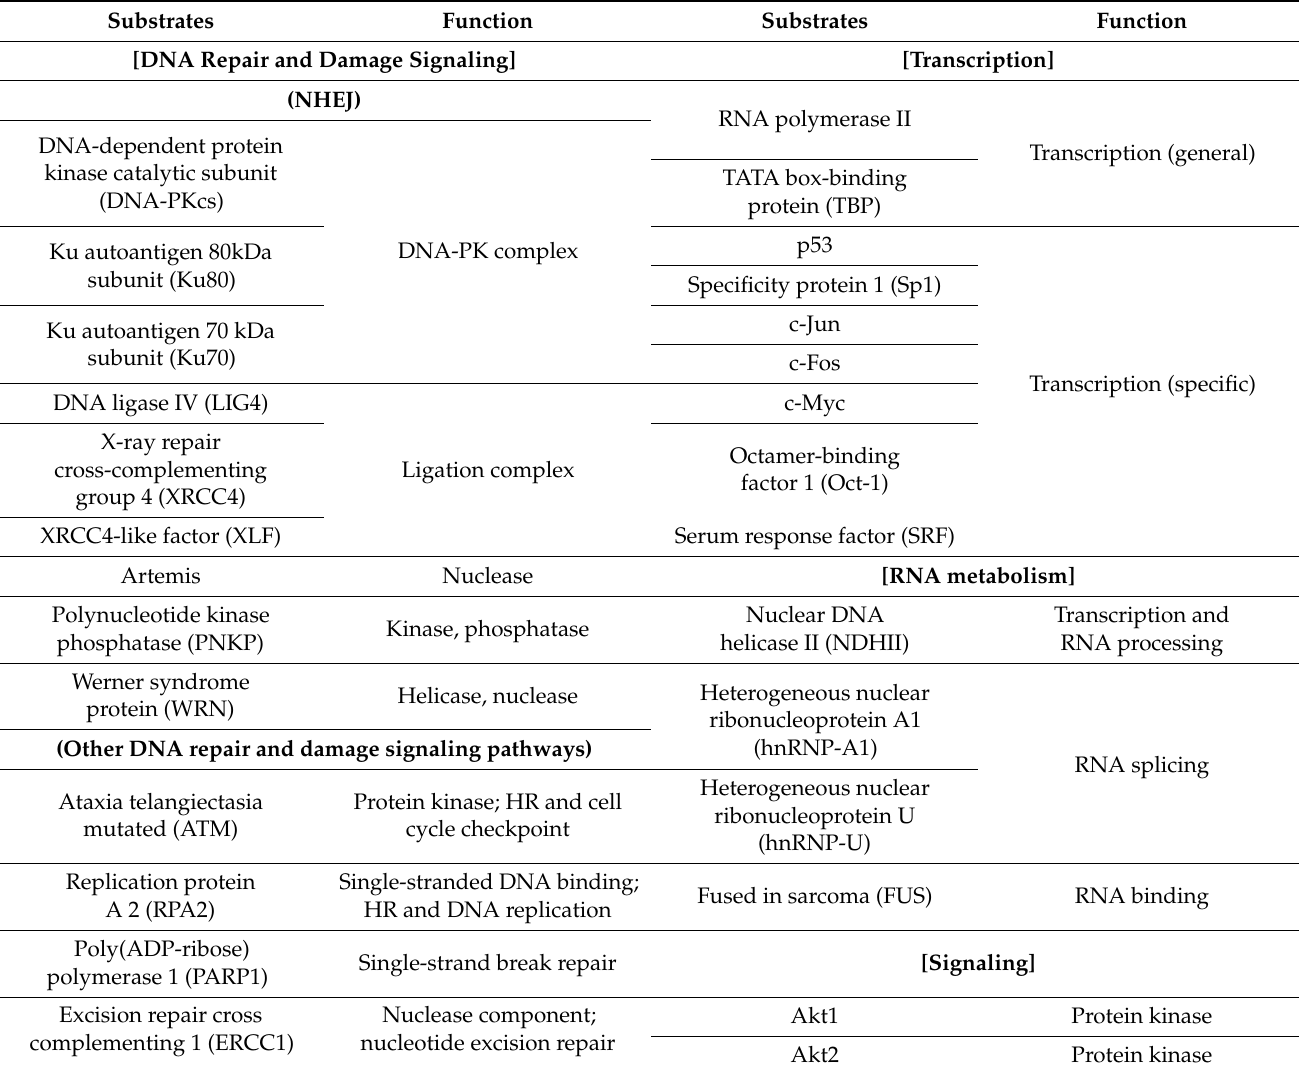
Table 1. DNA-PK substrates and their